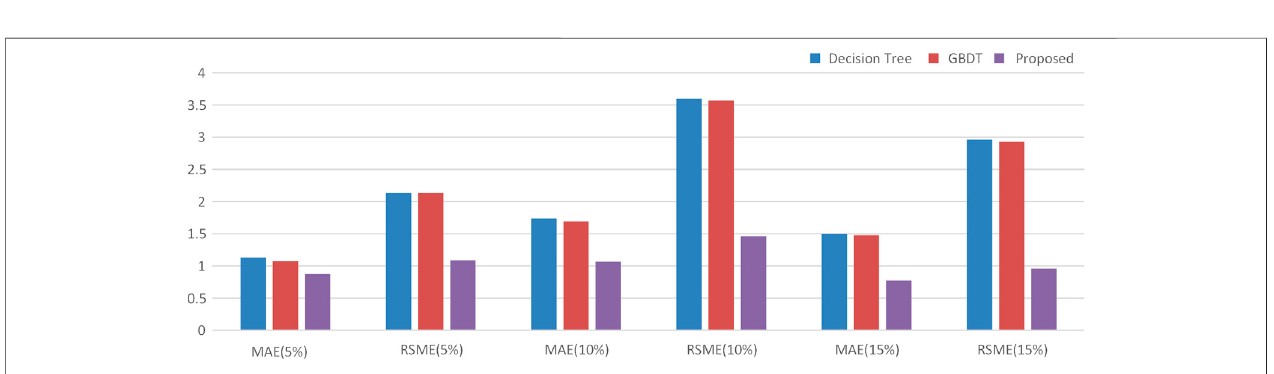
FIGURE 11 | The histogram of the comparative analysis in different outliers repairing methods.